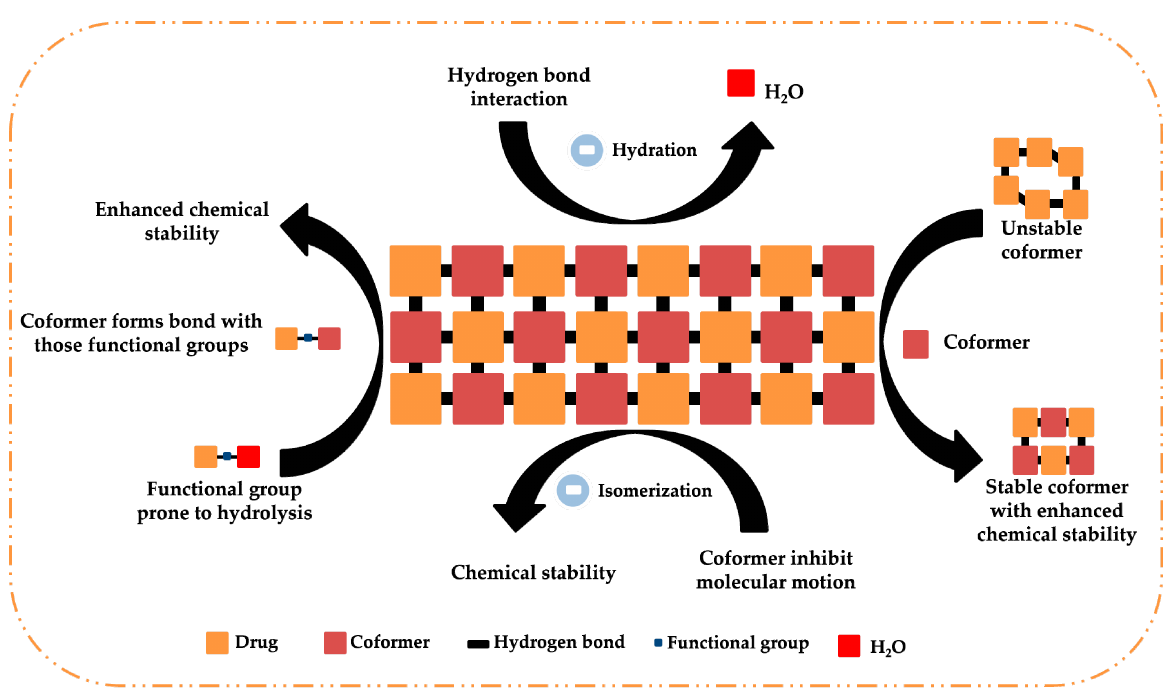
Figure 8. Role of coformers in stabilizing the drug molecule.